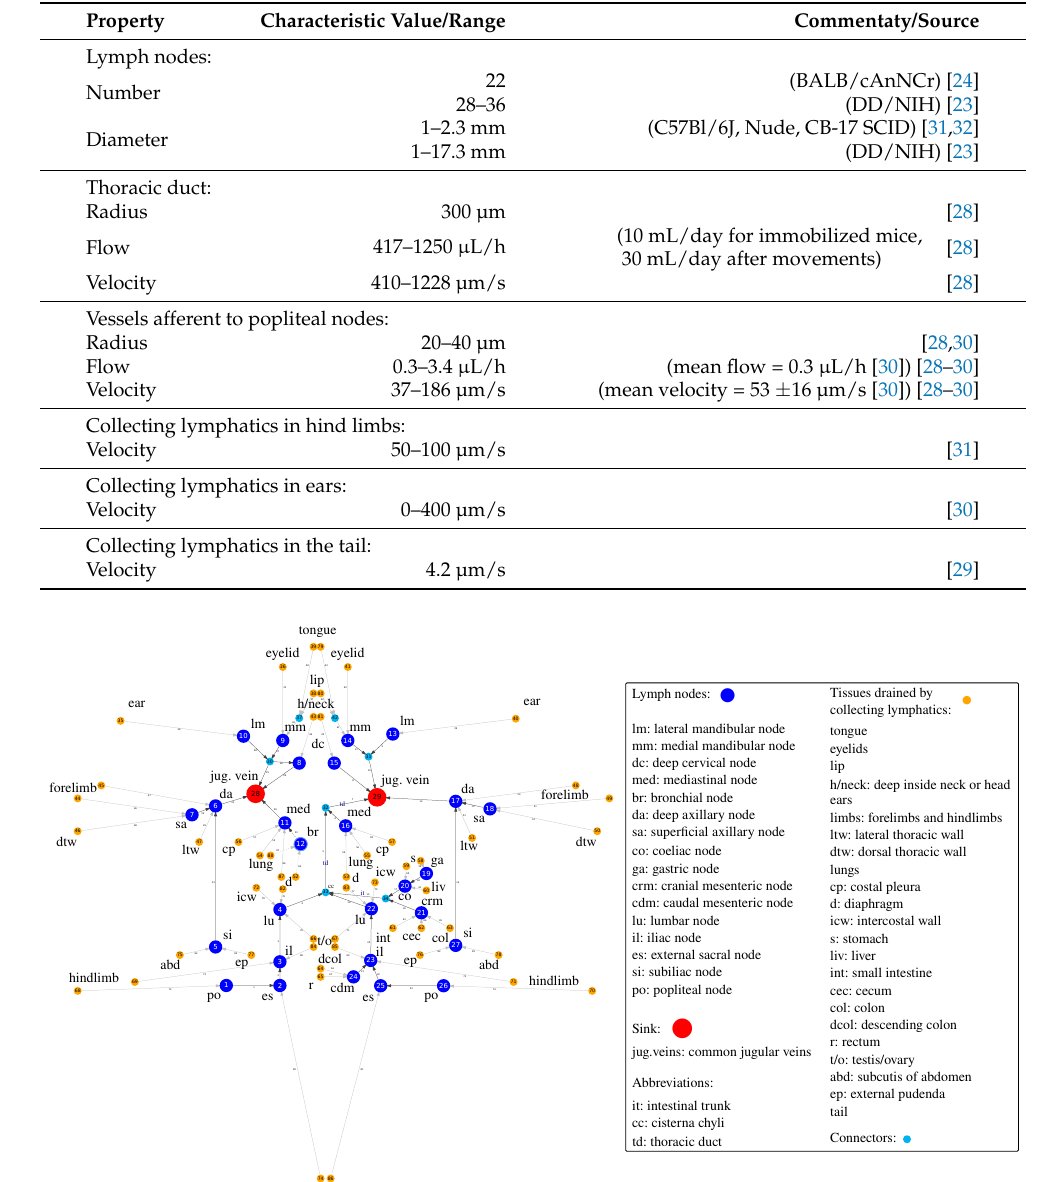
Table 1. Physiological and anatomical properties of the murine lymphatic system.